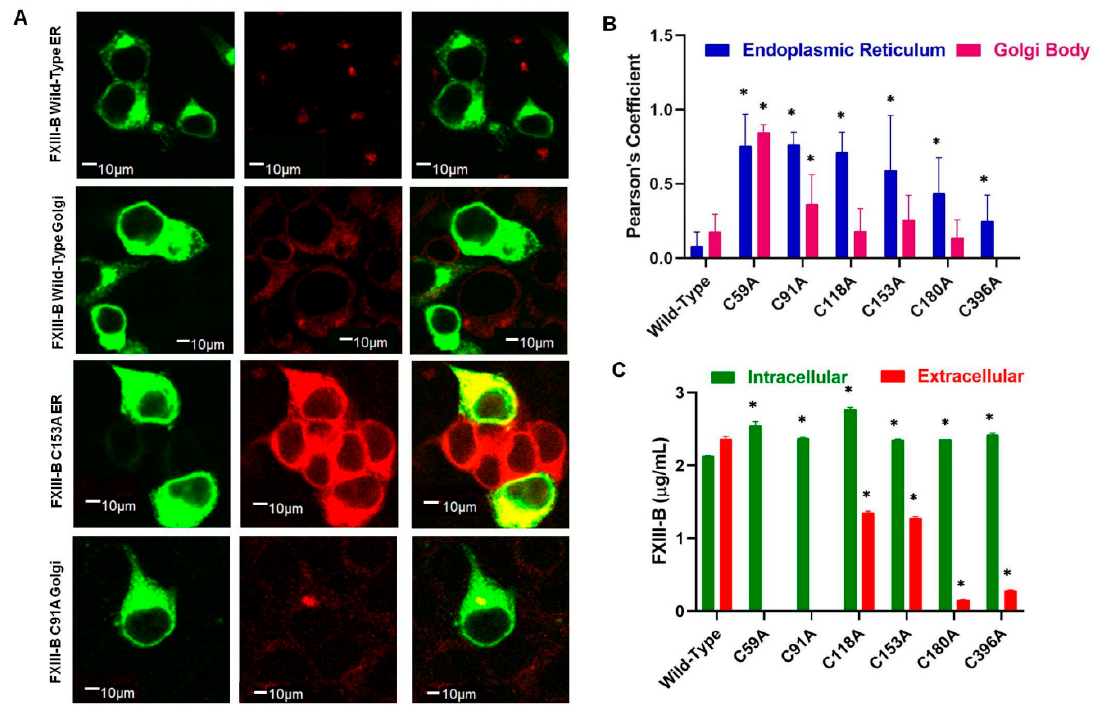
Figure 2. Effect of FXIII-B cysteine mutations on intracellular trafficking of FXIII-B protein. Panel A. Confocal microscopy tracking the subcellular localization of FXIII-B cysteine mutant proteins, via cell-specific markers; green ( α FXIII-B), red ( α -PDI (for endoplasmic reticulum) and α -TGN-46 (for trans-Golgi network)) with secondary antibodies conjugated with Alexa-488 and Alexa-555 respectively. Bars represent 10 µ m scale. Panel B . Bar-plot representation of Pearson’s coefficient calculated as a measurement of the intensity of pixels, defining co-localization of FXIII-B within either endoplasmic reticulum (PDI), or trans-GGolgi network (TGN-46). A “*” symbol represents significance ( p -value < 0.05). Panel C. Bar plot representation of antigenic evaluation (ELISA) of select FXIII-B cysteine mutants which showed higher intracellular retention (on confocal immunostaining) when compared to wild-type. A “*” symbol represents significance (p-value <